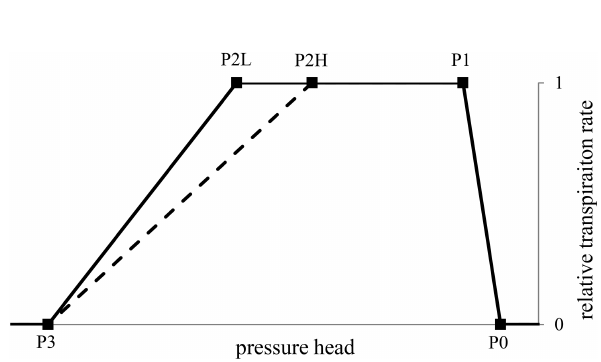
Figure B1. The relative transpiration rate as a function of soil water pressure head according to Feddes et al.